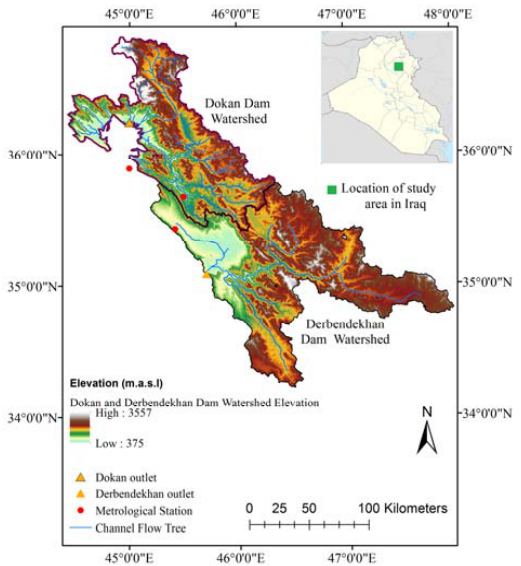
Table 1. Properties of the Dokan and Derbendekhan watersheds.